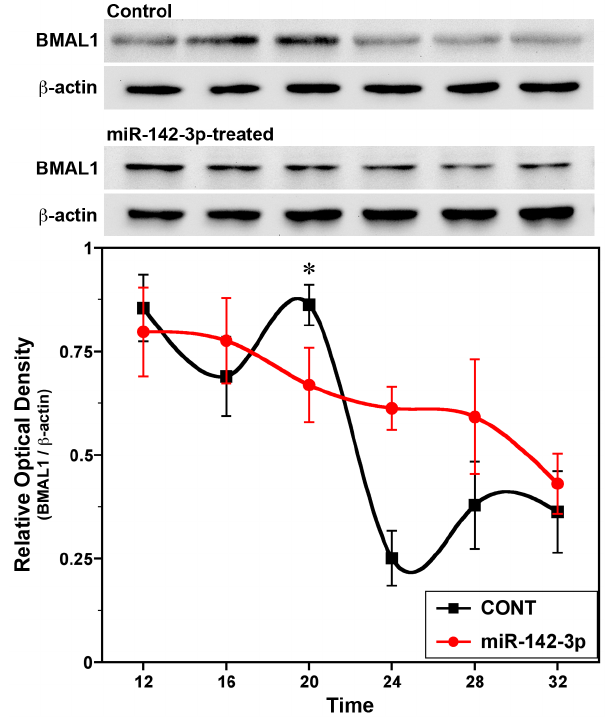
Figure 4. Effects of miR-142-3p overexpression on the circadian rhythm of BMAL1 protein content in immortalized SCN cells invitro . Representative Western blot results and densito- metric determinations of BMAL1 protein levels at 4-hour intervals in cultures (n=4–5) of mPer2 Luc SCN cells transfected with pEZX-MR04 control miRNA expression vector ( CONT ) or pEZX-MR04 miR-142 expression vector ( miR-142 ). The plotted values represent the relative optical density (mean 6 SEM) and correspond to the ratios of BMAL1/ b - actin immunoreactive signal in each sample. The asterisk indicates that the peak in BMAL1 protein levels at 20 hr was significantly greater ( p , 0.05) than that observed during succeeding minima.